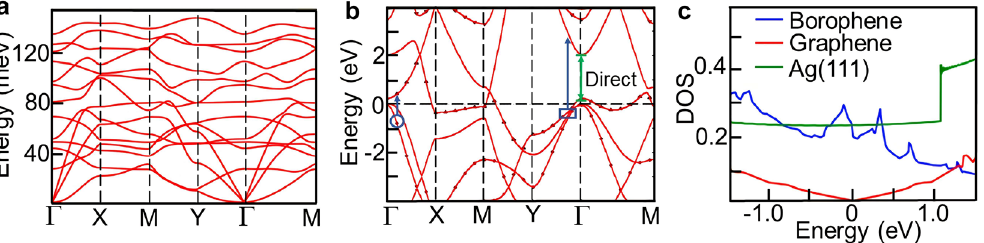
Figure 2: Phonon dispersions and band structures of borophene monolayer. (a) Phonon dispersion and (b) band structure of borophene monolayer. The black scatters represent band structures calculated by DFT calculations, and the red lines are obtained through interpolation of MLWFs. The green double arrow in (b) indicates the direct band gap of about2eVat Γ point.(c)Densityofstates(DOS)ofborophene,graphene,andAg(111)monolayers(withathicknessof t 2D ≈ 2.36Å)withtheunit of states/eV/atom. The Fermi levels in (b) and (c) are set to 0